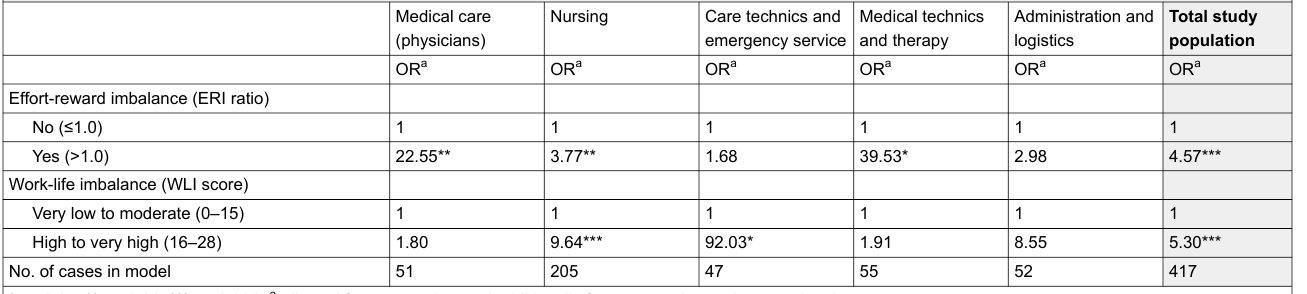
Table 5: Associations between both imbalance measures and increased burnout symptoms (CBI score ≥50) among different professional